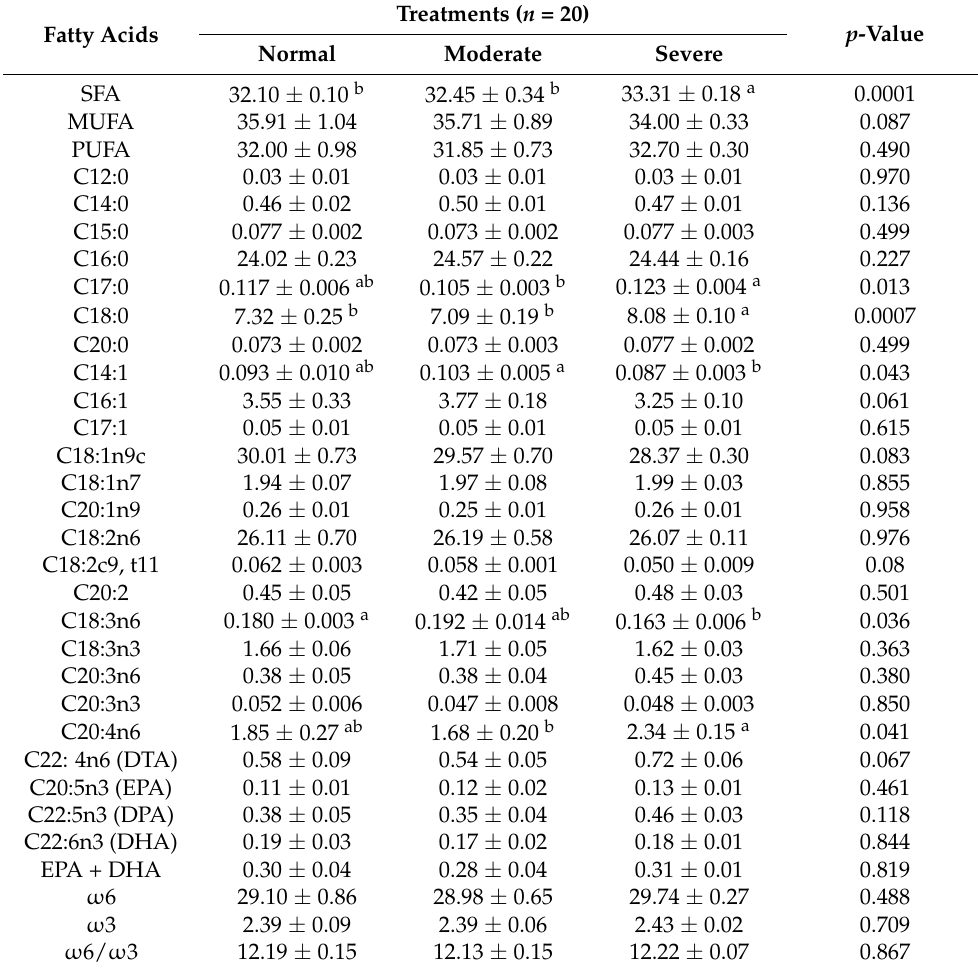
Table 6. Fatty acid composition (% of total fatty acids) of breast meat fat from Cobb MX broilers affected by